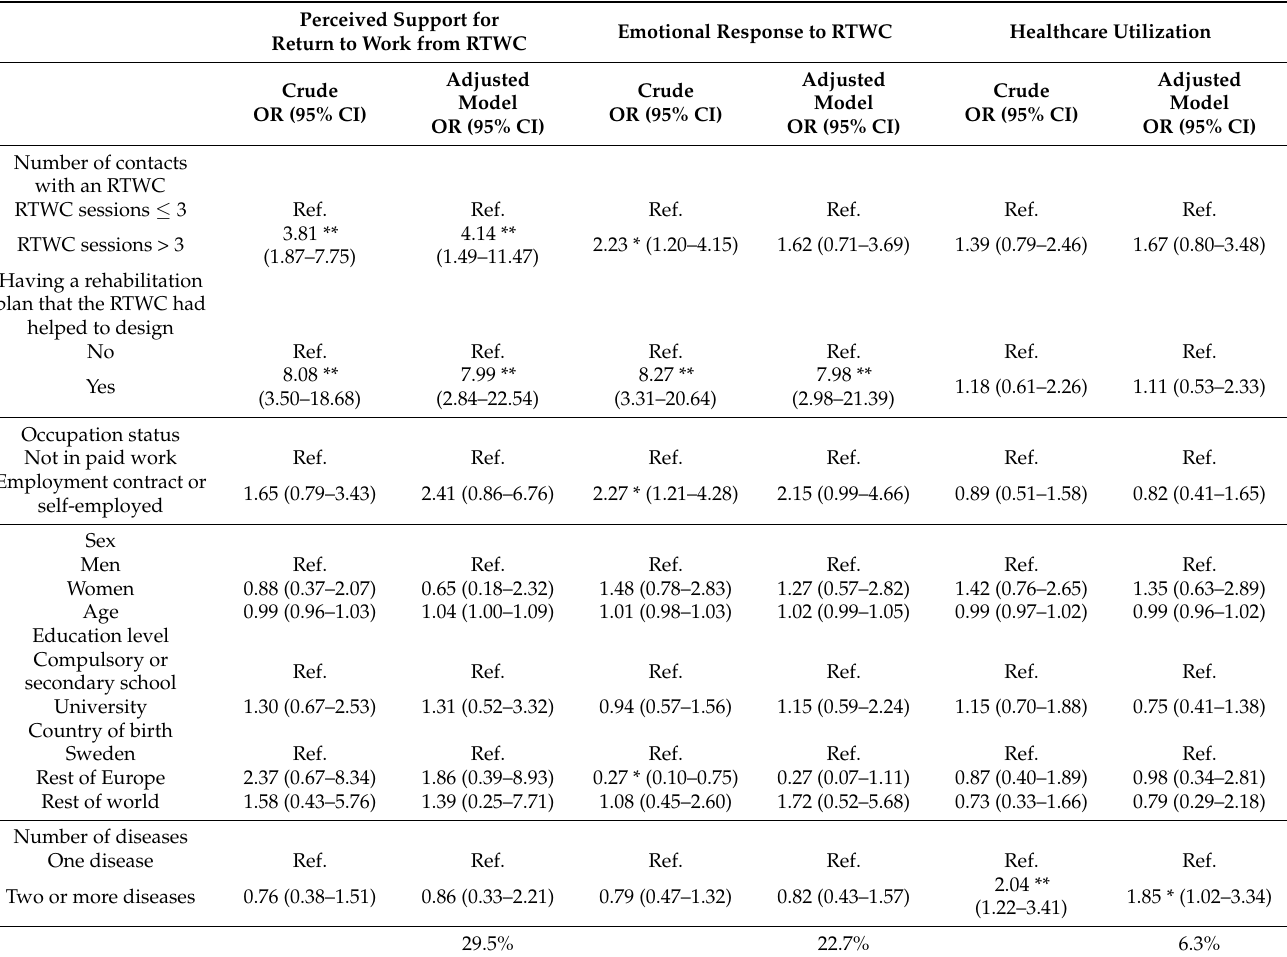
Table 3. Binary logistic Regressions presenting odds ratios explaining perceived support for return to work from an RTWC, emotional response to RTWC, and reporting higher healthcare utilization. Perceived Support for Return to Work from